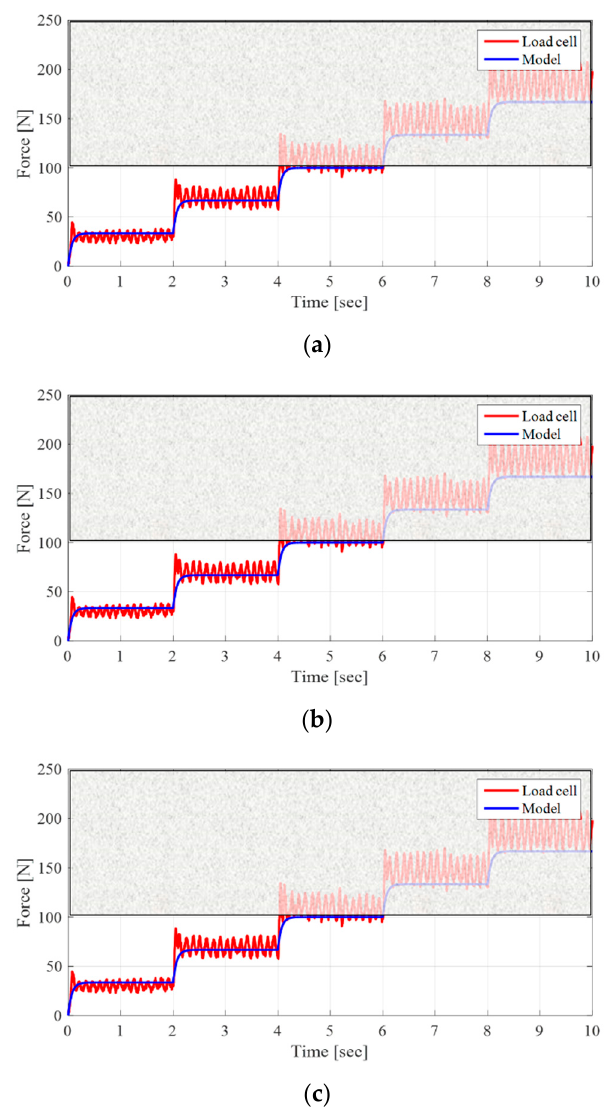
Figure 2. Experimental results of system identification: ( a ) Empty film; ( b ) Half film; (c) Full film.